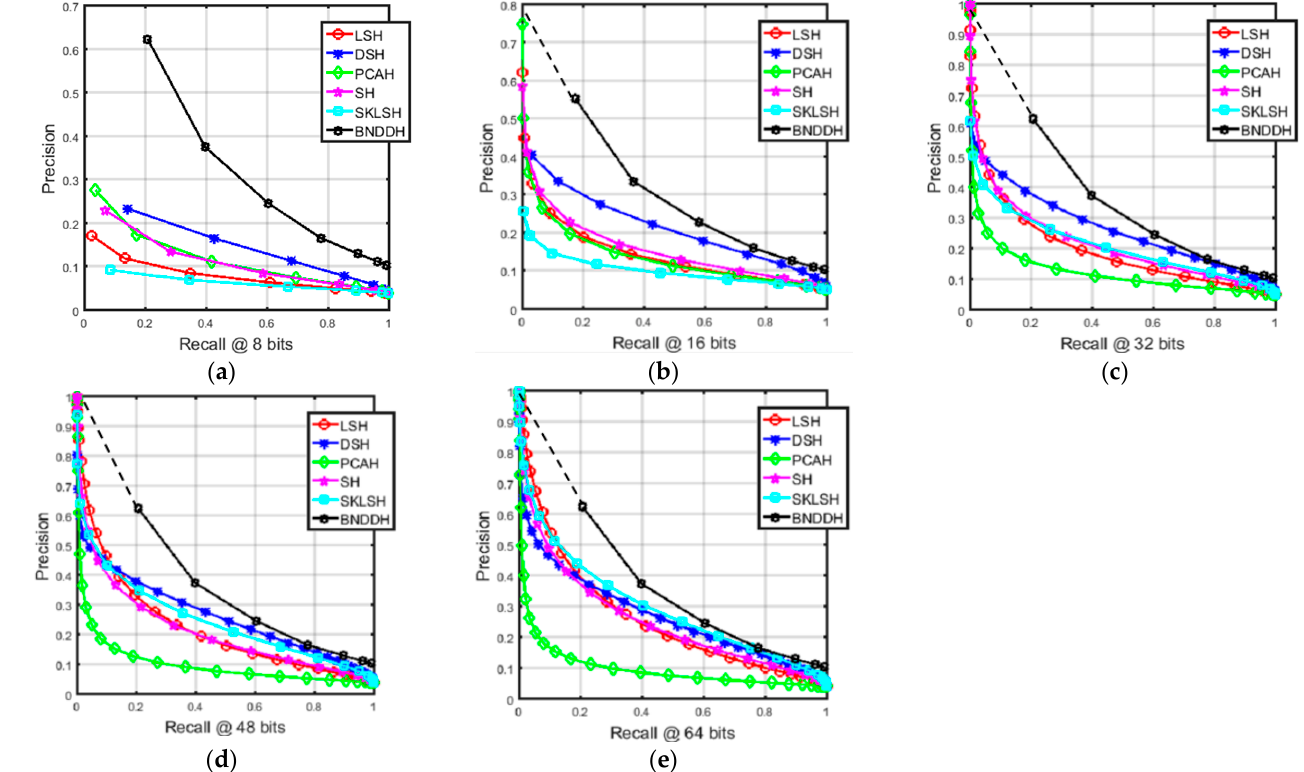
Figure 5. Precision–recall on the CIFAR-10 database ( a ) @8-bits ( b ) @16-bits( c ) @32-bits ( d ) @48-bits ( e ) @64-bits.